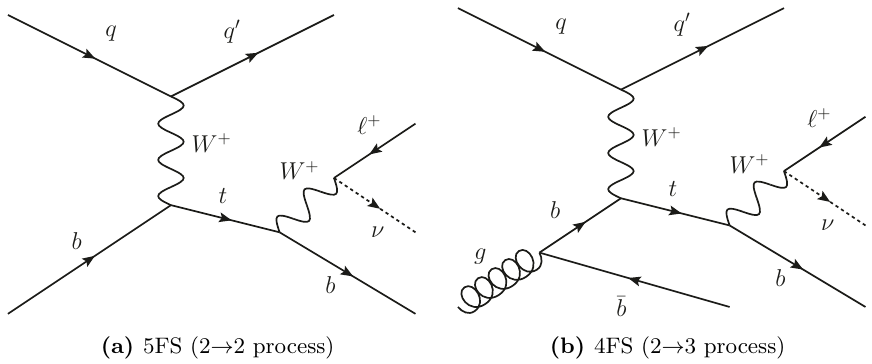
Figure 1. Representative LO Feynman diagrams for t -channel single-top-quark production and decay. Here q represents a u - or (cid:22) d -quark, and q 0 represents (a) a d - or (cid:22) u -quark, respectively, in which the initial b -quark arises from a sea b -quark in the 5FS or 2 2 process, or (b) a gluon ! splitting into a b (cid:22) b pair in the 4FS or 2 3 !